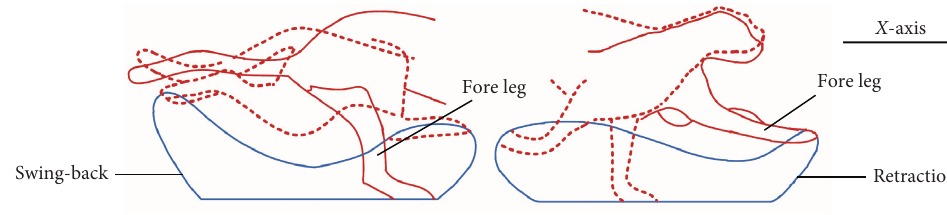
Figure 7: Track curve of cheetah